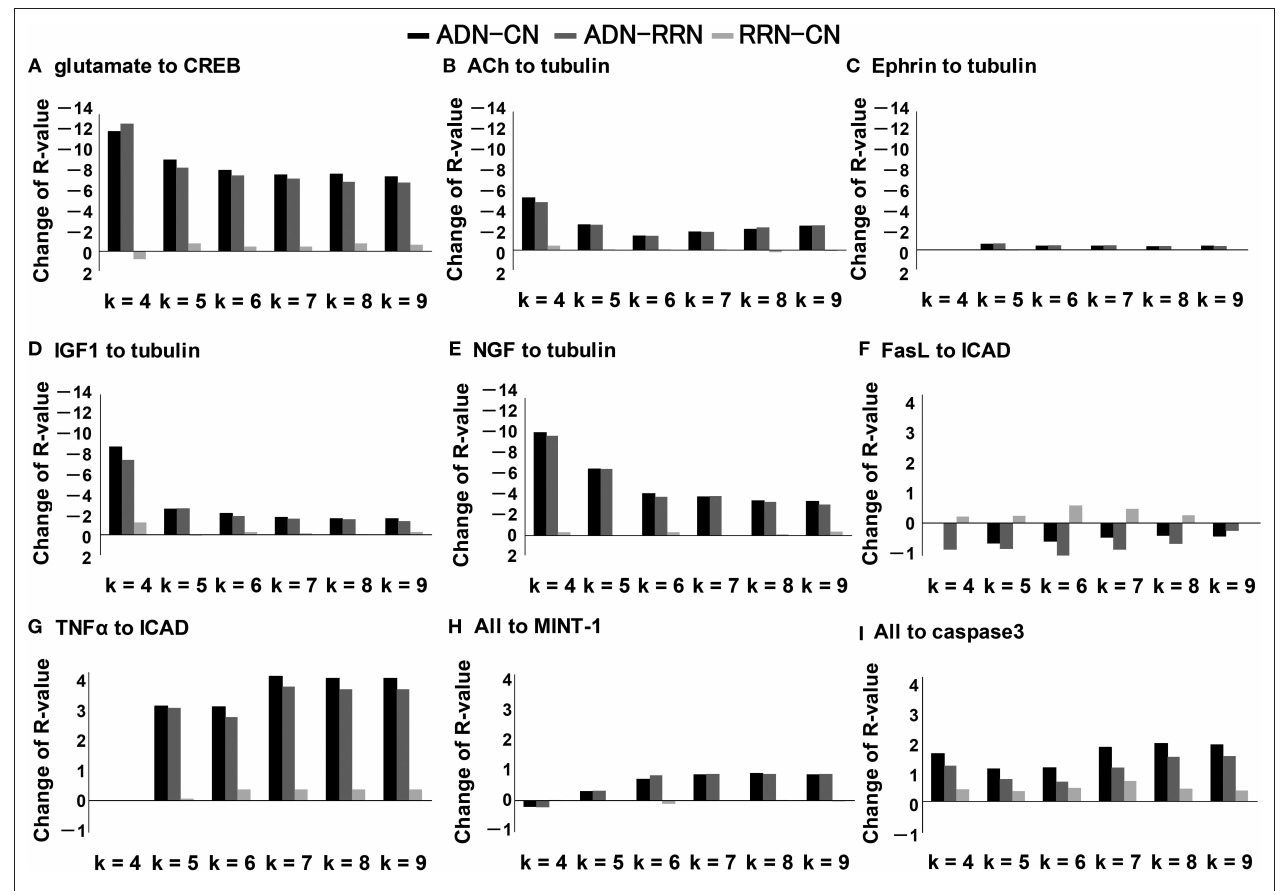
FIGURE 3 | Pathway robustness: individual input–output relationships in ADN subtracted by CN, ADN subtracted by RRN, and RRN subtracted by CN ( k = 4, 5, … , 9). (A) Robustness changes in the pathways associated with neuronal plasticity: input is glutamate and output is CREB. (B–E) Robustness changes in the pathways associated with neurite outgrowth: inputs are ACh, Ephrin, IGF1, and NGF, and output is tubulin. The decrease